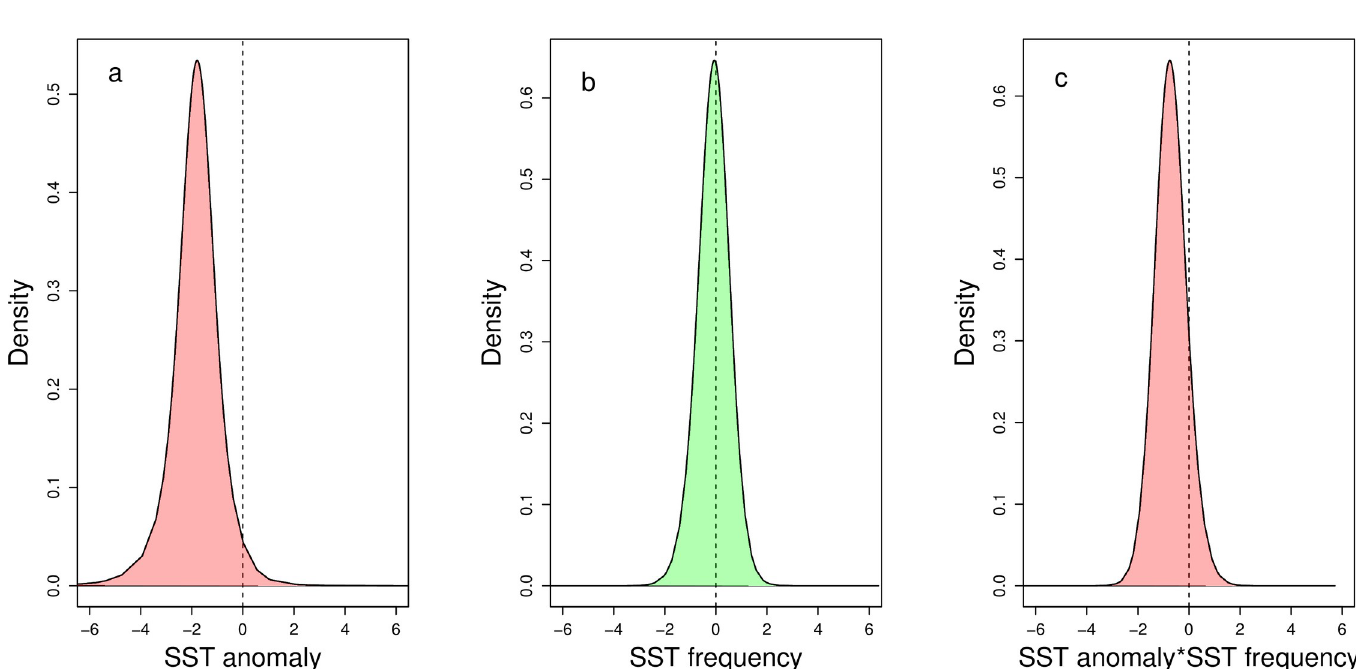
Fig 6. Posterior marginal distributions of fixed effects in the integrated nested laplace approximation model for: (a) sea surface temperature (SST) anomalies, (b) return frequency of SST, and (c) the interaction between SST anomalies and return frequency of SST averaged from 6 January 2000 to 26 December 2019 at each of the six Pacific Ocean study locations [i.e., at Palau and Yap (2017), Pohnpei and Kosrae (2018), and Majuro and Kiritimati (2019)]. Where the dashed lines represent zero, the pink shading represents negative effects, the green shading represents neutral effects, and the � indicates multiplication.